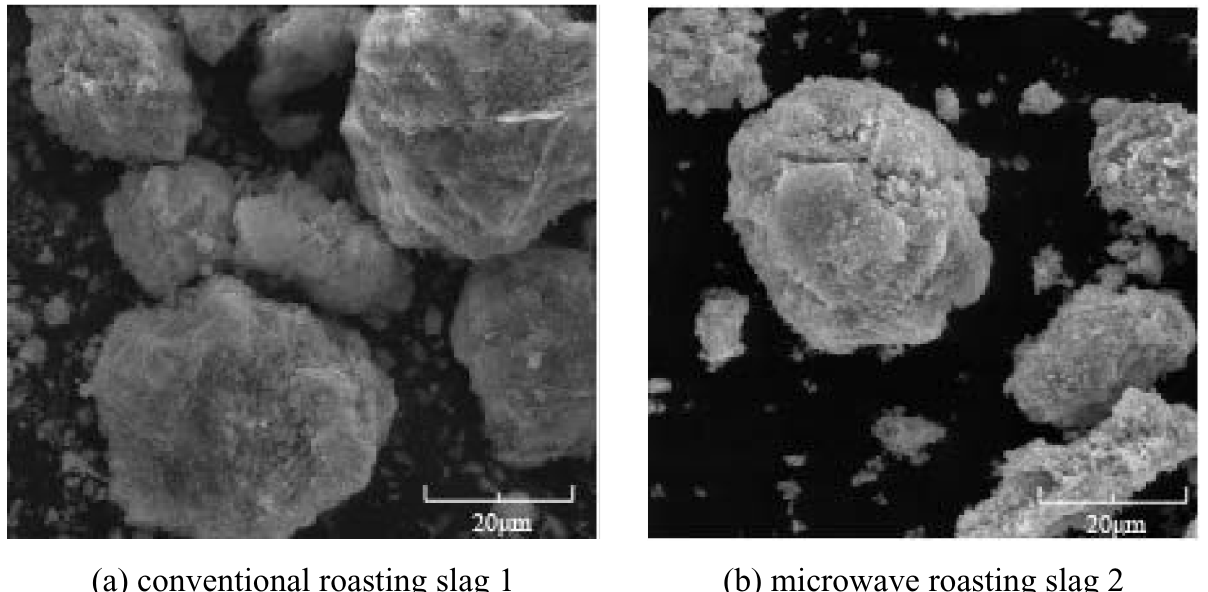
Figure 10: SEM images of oxidizing roast slag using conventional and microwave roasting.